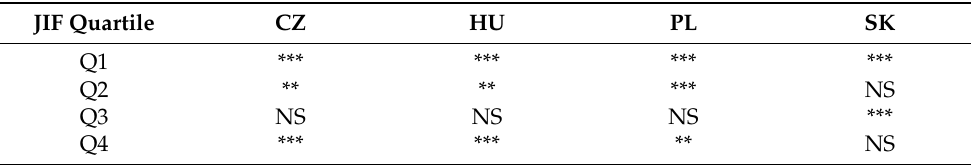
The level of significance is marked by starts: ** p < 0.01; *** p < 0.001; NS = not